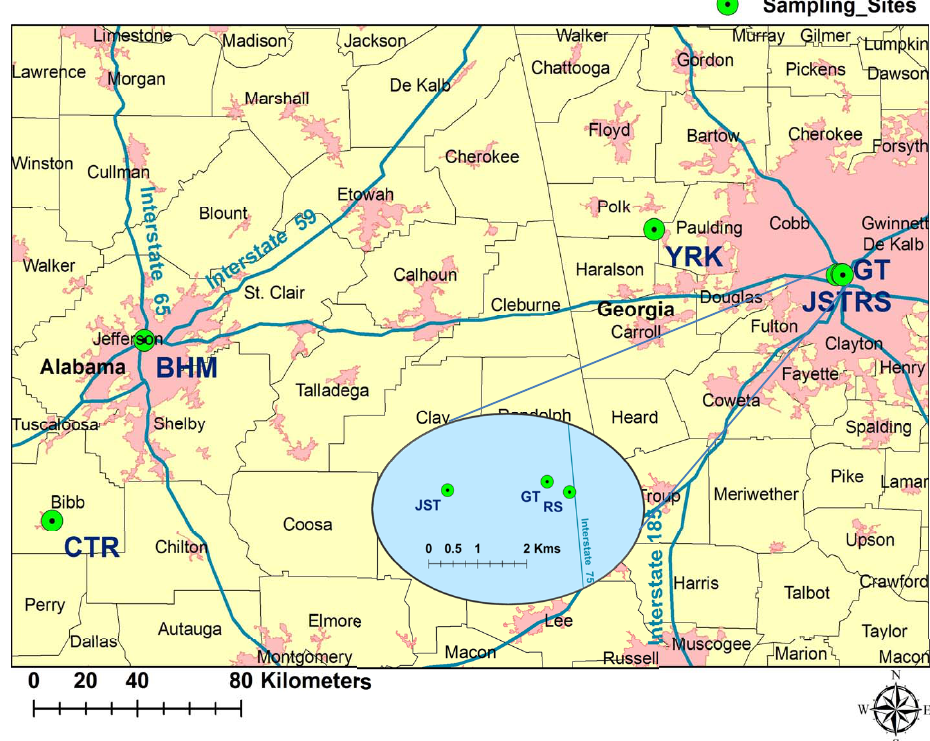
Figure 1. Map of sampling